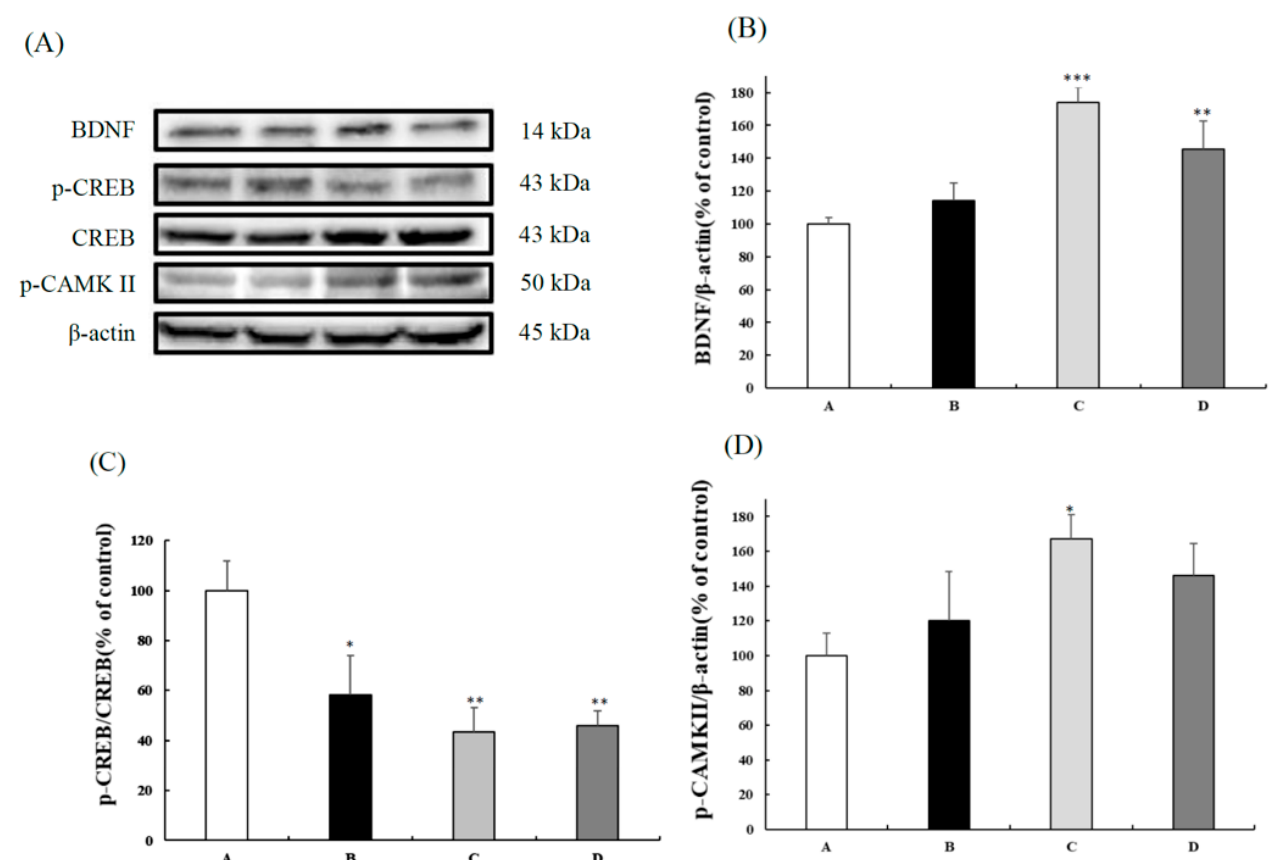
Figure 2. Protein expressions of the livers in 3-month-old male SAMP8 mice fed with different diets for 12 weeks. ( A ) The gel picture BDNF, p-CREB, total CREB, p-CAMK II, and β -actin expressions. ( B ) BDNF, ( C ) p-CREB/total CREB ratio, and ( D ) p-CAMK II expressions of the liver among different groups. The y axis quantified by the western blot analysis protein of BDNF/ β -actin, p-CREB/CREB ratio, and p-CAMKII/ β -actin are expressed as the percentage of control. Values are displayed as mean ± S.E.M. and were analyzed by one-way ANOVA ( n = 6/group). * p < 0.05, ** p < 0.005, *** p < 0.001 compared to the control group. A = SAMP8 control, B = 50 mg/kg BW/day CB, C = 100 mg/kg BW/day CB, D = 200 mg/kg BW/day CB.